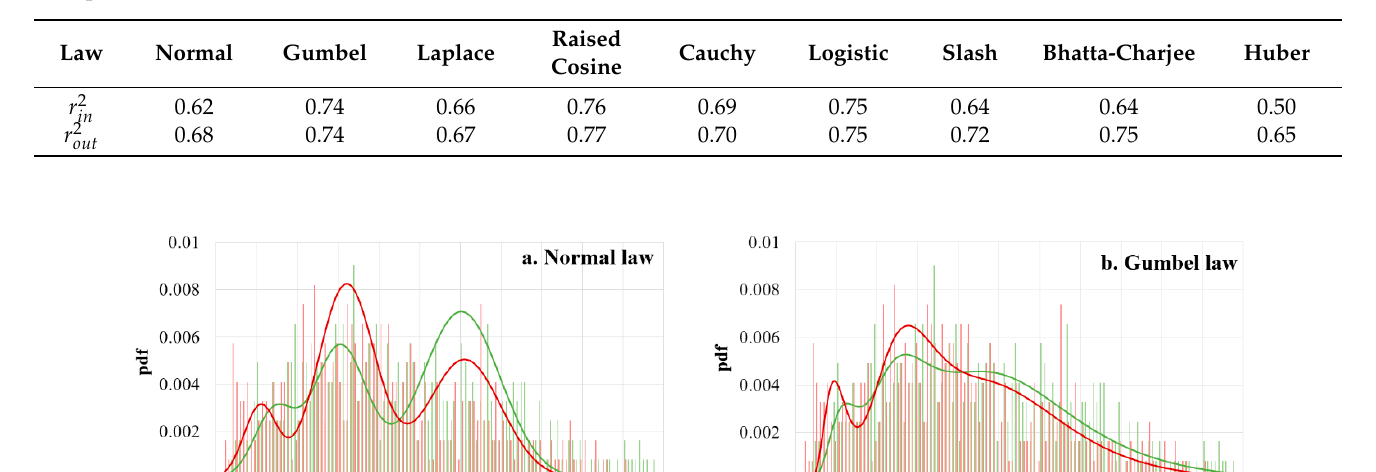
Table 6. Pearson’s correlation coefficients between the distributions with negative slope of groundwater evolution, and the theoretical composite pdf ; r 2 applies to measurements inside prediction interval, r 2 applies to measurements outside the prediction interval.